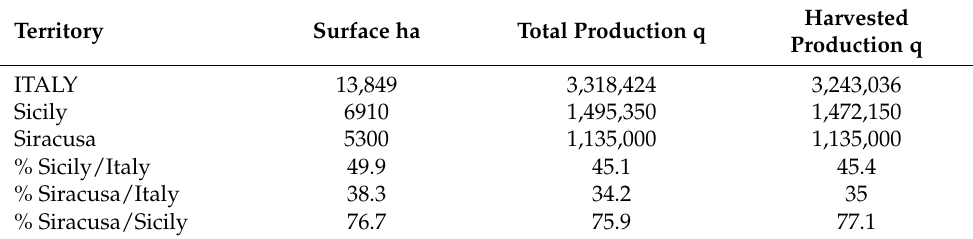
Harvested Production q